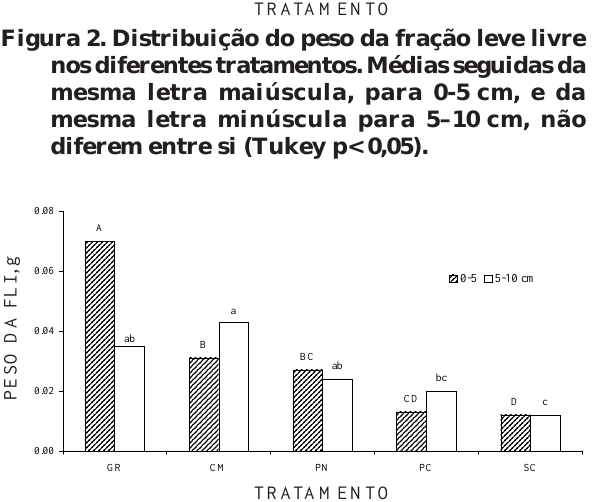
Figura 3. Distribuição do peso da fração leve intra- agregado nos diferentes tratamentos. Médias seguidas da mesma letra maiúscula, para 0- 5 cm, e da mesma letra minúscula para 5–10 cm, não diferem entre si (Tukey p <